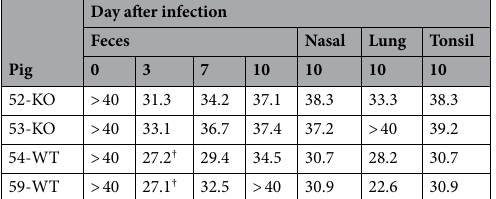
Table 1. A qRT-PCR results for fecal-nasal swabs and tissues from the first SVA challenge. † Positive for SVA by virus isolation. PCR results are presented as Ct